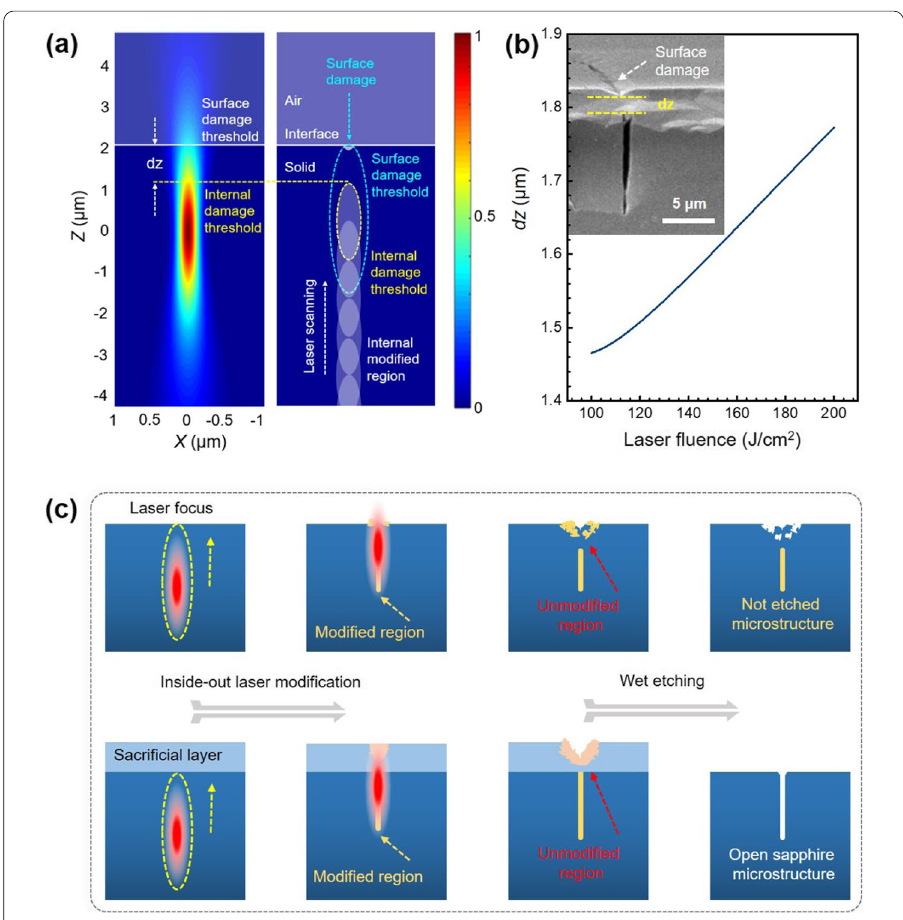
Fig. 1 (a) Optical field distribution of a Gauss laser beam and the schematic program of inside‑out femtosecond laser scanning technology. (b) The dependence of the depth of the undamaged region (d_z) on the laser fluence (A_0^2). The inset is the SEM image of a typical undamaged region. (c) The schematic illustration of laser modification and subsequent wet etching of sapphire surface without and with a sacrificial